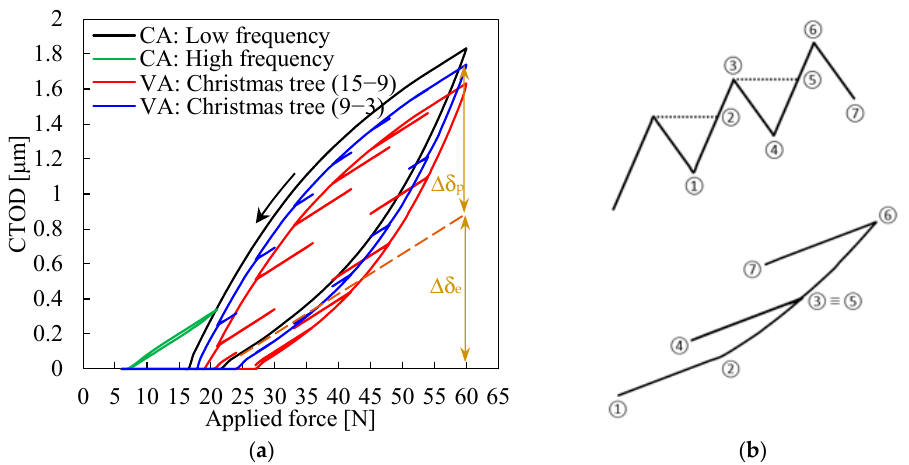
Figure 4. Comparison of different loading spectrums: ( a ) CTOD curves evaluated for a = 15.3 mm. ( b ) Detail of applied load and of CTOD versus load plot.